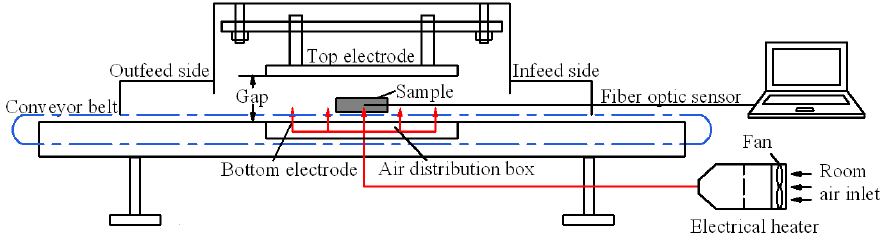
Figure 2. Schematic view of the pilot-scale 6 kW, 27.12 MHz RF system (Adapted from Wang et al. [33]).